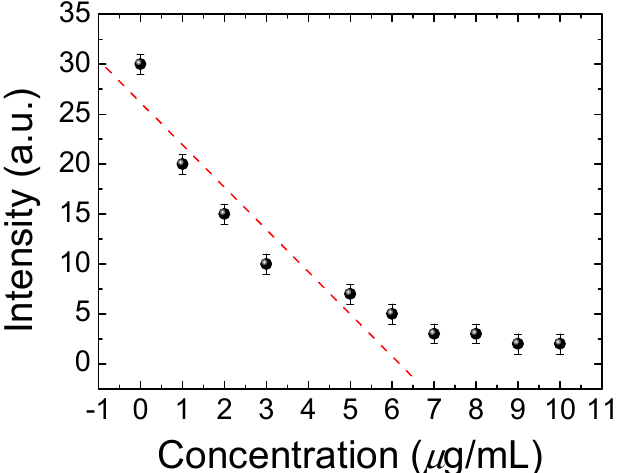
Figure 4. The linear correlations of the intensity of dye-doped liquid crystal (DDLC) multi-microfluidic chips at various concentrations of bovine serum albumin (BSA).